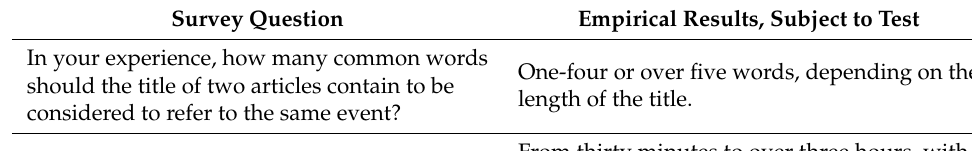
Table 1. Empirical rules regarding the criteria for announcing an event as